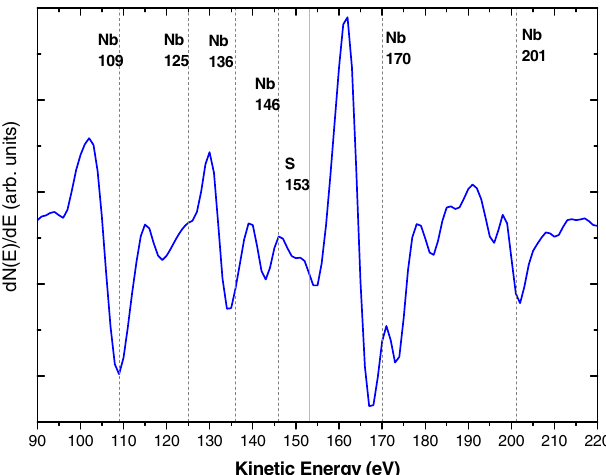
FIG. 4. AES spectrum of sample 2 (spot 5). No sulfur peak was found at 153 eV. The spectra surveyed at other spots indicate no sulfur